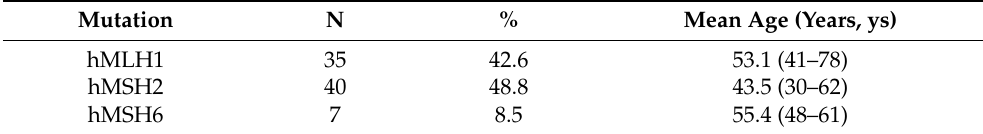
Table 2. Frequency of MMR gene mutations in LS-related